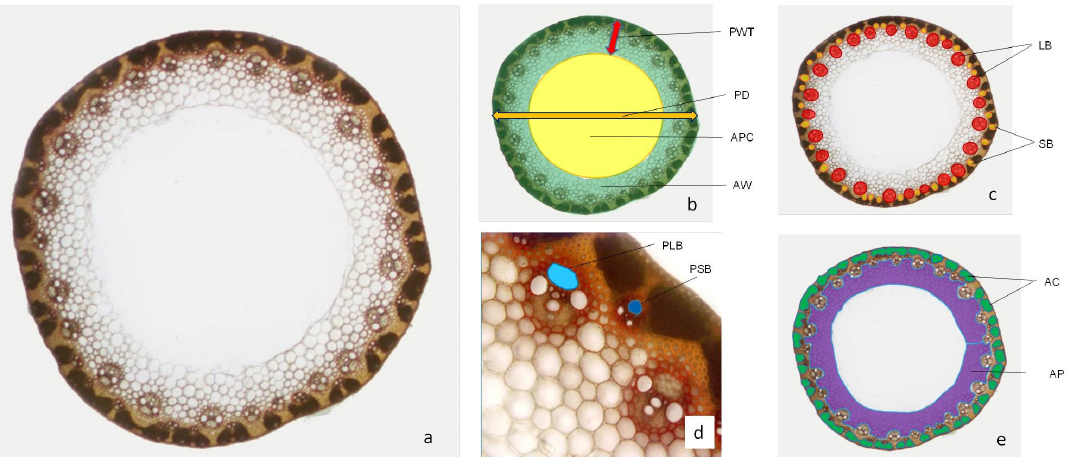
Figure 1. Cross-section of wheat peduncle stained with phloroglucinol–hydrochloric acid ( a ); PD—peduncle diameter, PWT—peduncle wall thickness, AW—area of peduncle wall, APC—area of pith cavity ( b ); LB—large vascular bundles, SB—small vascular bundles ( c ); PLB—phloem area in large vascular bundle, PSB—phloem area in small vascular bundle ( d ); AC—area of chloren- chyma on whole peduncle section, AP—area of parenchyma on whole peduncle section ( e ).